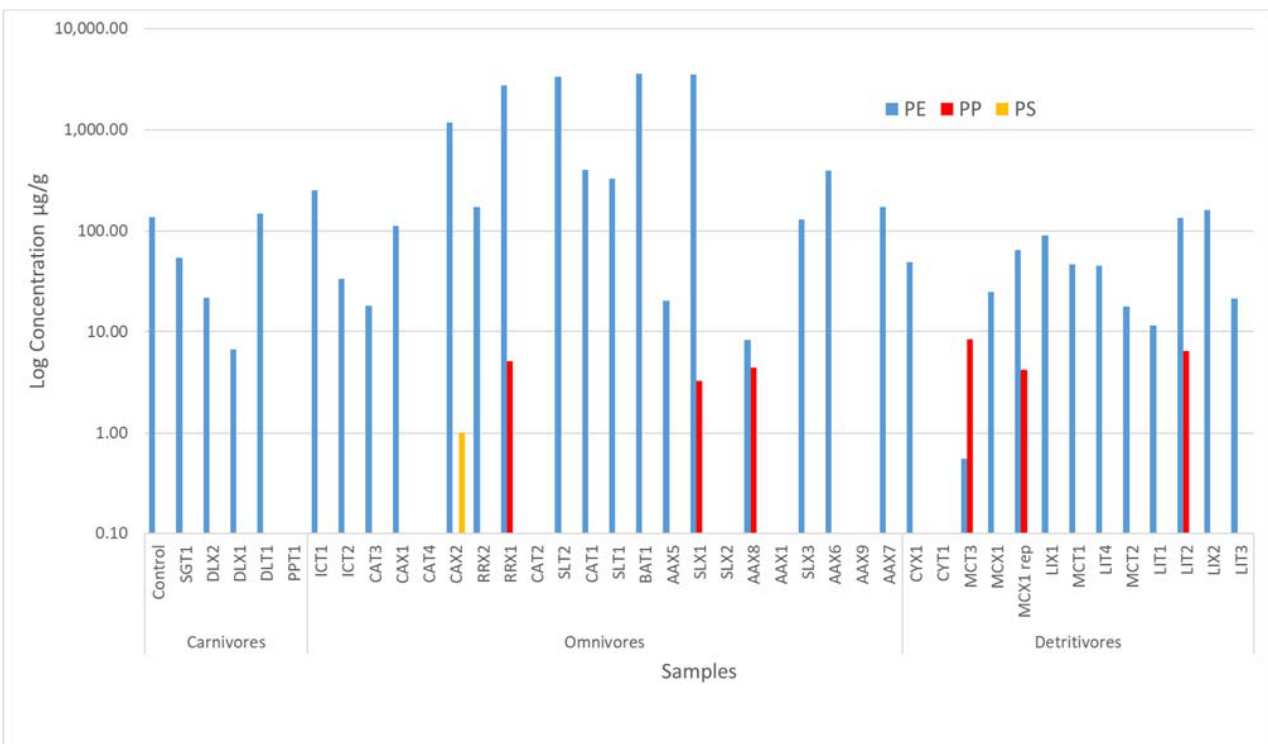
Figure 2. Frequency of polymer detection in the GIT samples.